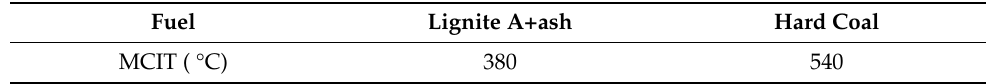
Table 3. Minimum cloud ignition